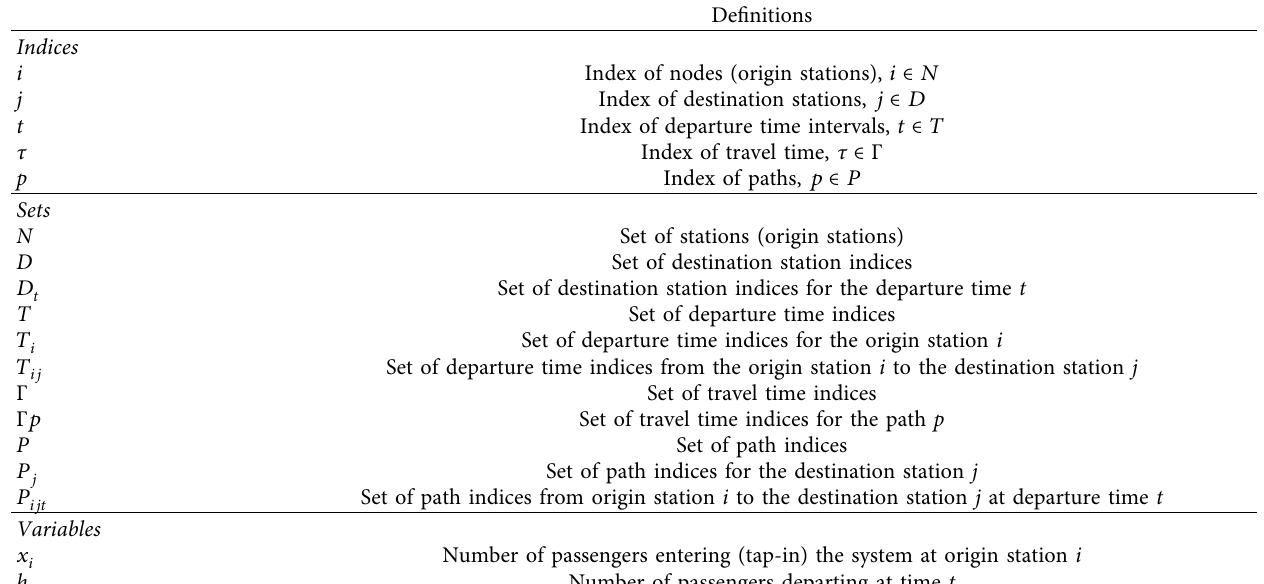
Table 1: Sets, indices, variables, vectors, and